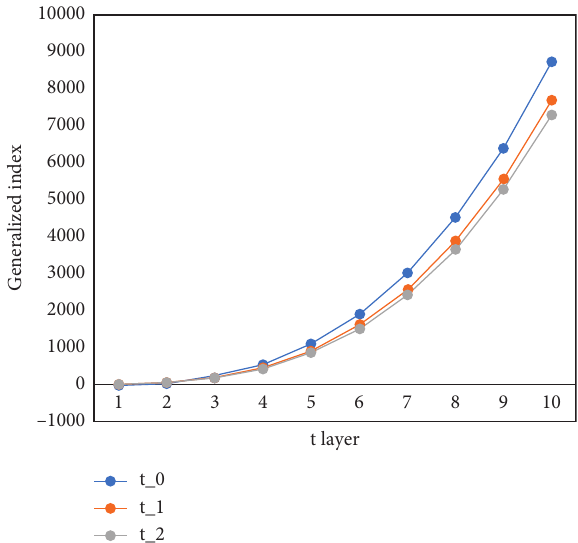
P ) using Table 3. m + Q k n